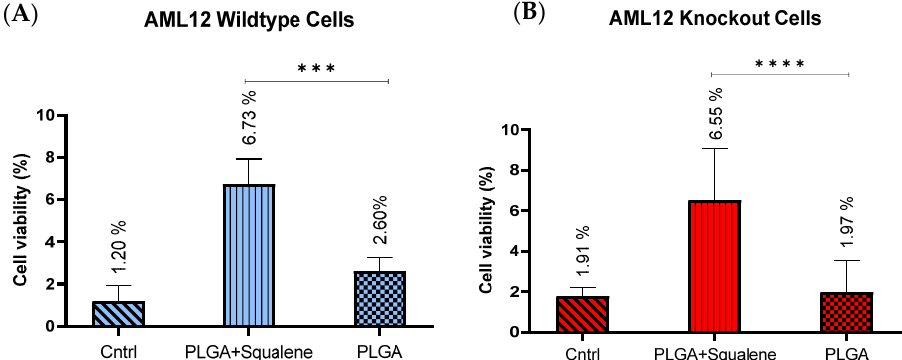
Figure 7. The cell viability evaluation of mouse hepatocytes upon ER stress. After 72 h, treated with 30 µM of squalene-loaded PLGA nanoparticles, ER stress was induced by 18 nM of thapsigargin for 24 h. ( A , B ) PLGA NPs did not produce a substantial difference in cell viability when compared to the untreated cells. PLGA based squalene nanoparticles at the 18 nM of thapsigargin ( A ) produced an enhancement of approximately 6% on the cell viability in WT cells (cell viability is 2.60% in con-